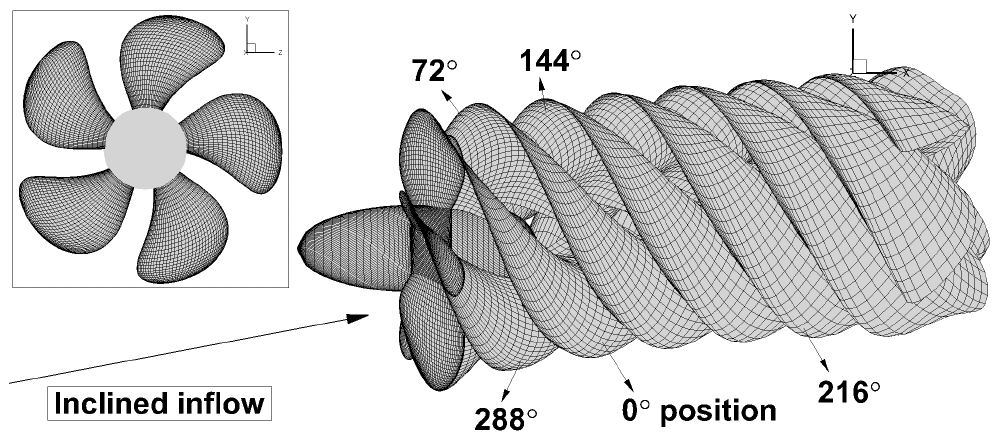
Figure 12. Projected view of the fully aligned wake of DTMB4661 propeller with hub, which has elliptical shape at both ends. Geometry of the 5-bladed propeller is shown in a separate frame.